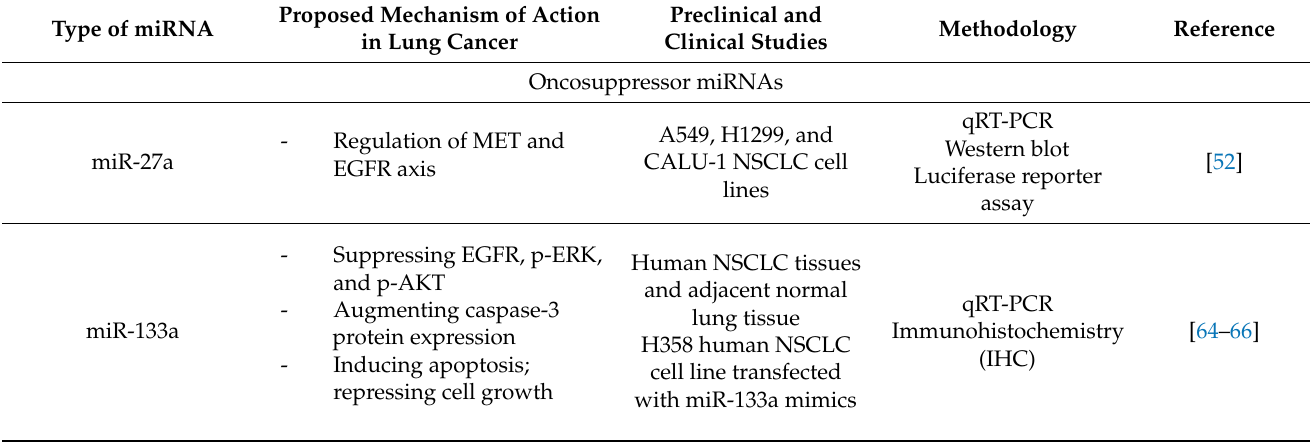
Table 1. Role of miRNAs via targeting EGFR or its downstream signaling in modulating lung cancer cell behavior in preclinical models and clinical